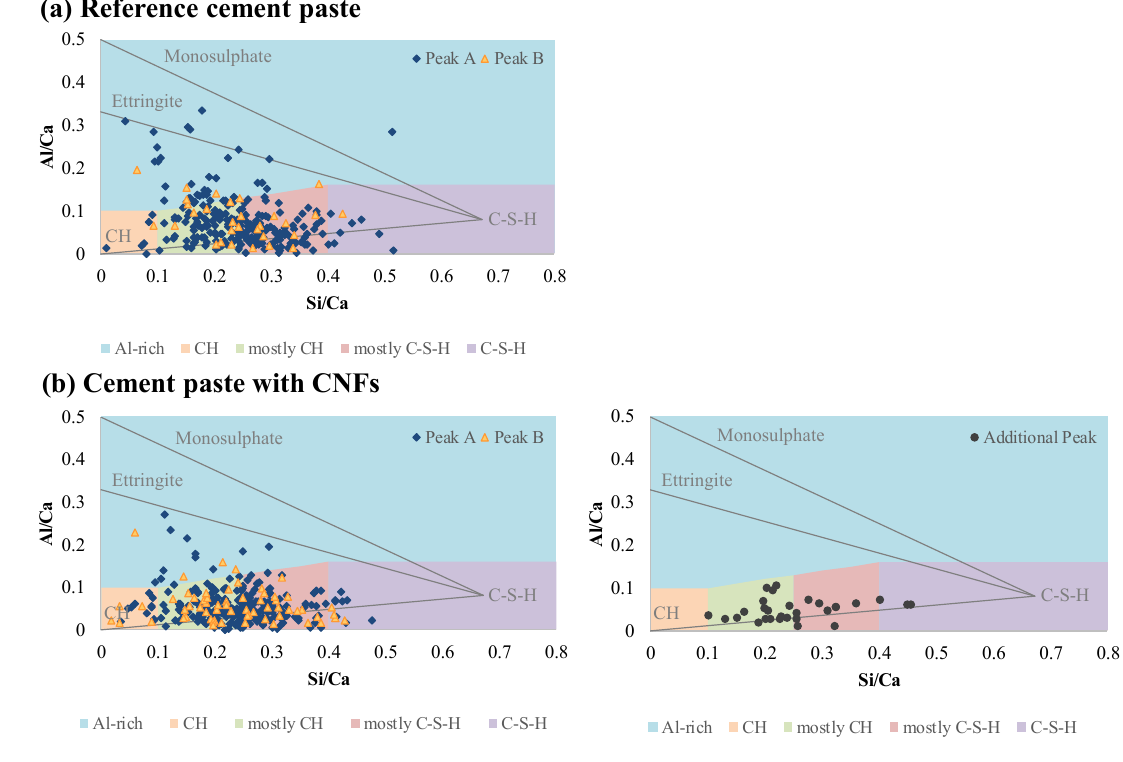
Figure 8. Segmentation of hydrates by chemical composition using SEM/EDS analysis for the ( a ) reference cement paste and ( b ) cement paste with CNFs.